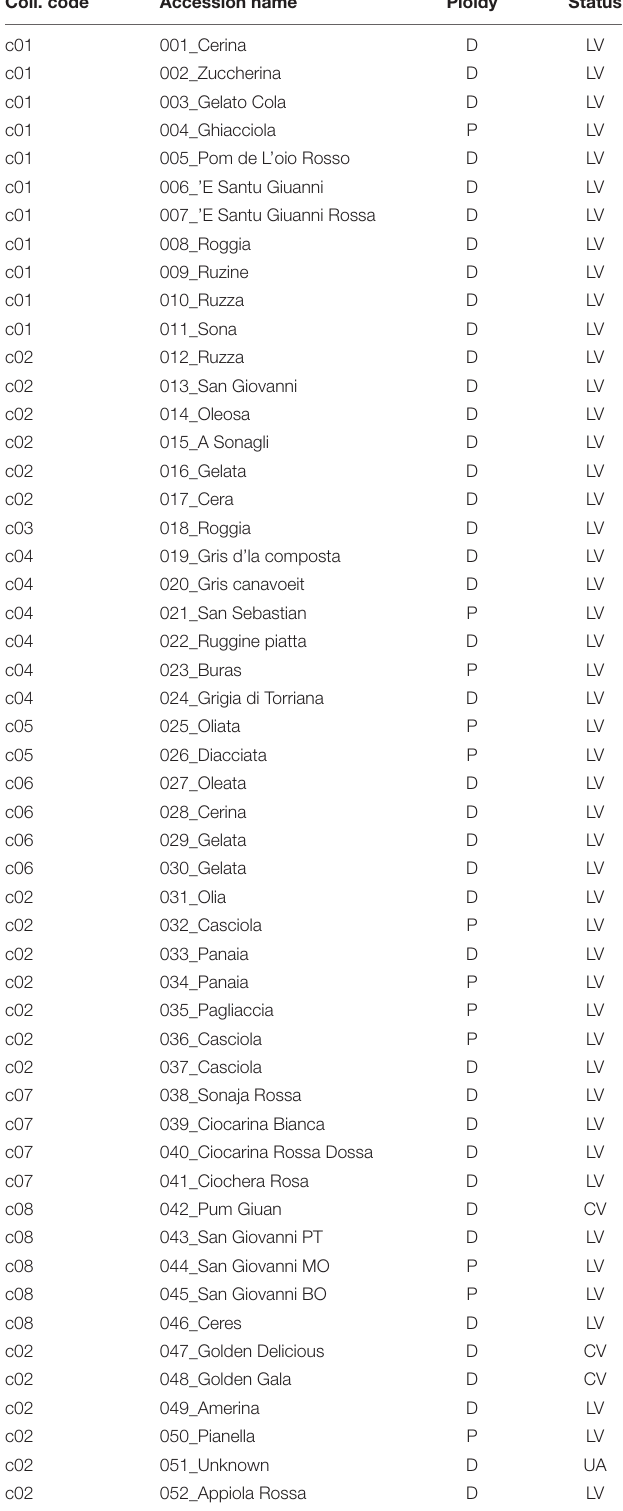
TABLE 1 | Collection code 1 , accession name, ploidy 2 (D, diploids; P, polyploids) and status (LV, local variety; CV, commercial variety; UA, unknown ) of 175 apple accessions used in the present